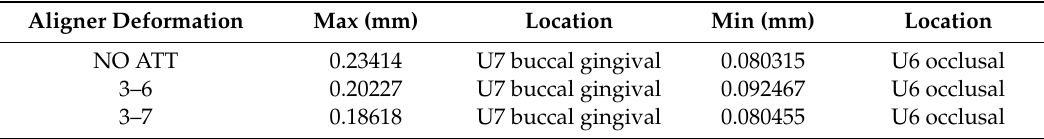
Table 2. Aligner deformation.